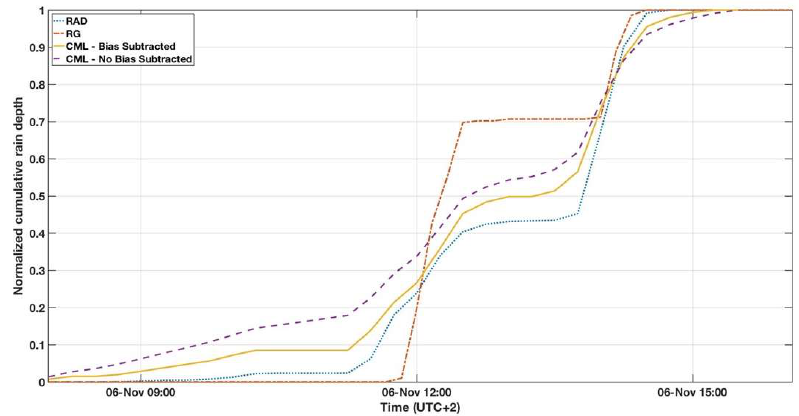
Figure 1. The experimental setup: the location of the weather radar, the CML, and the two Rain Gauges (Arad and Shani) are marked. This image is copied from [23], where the same experimental setup was used for a different purpose.